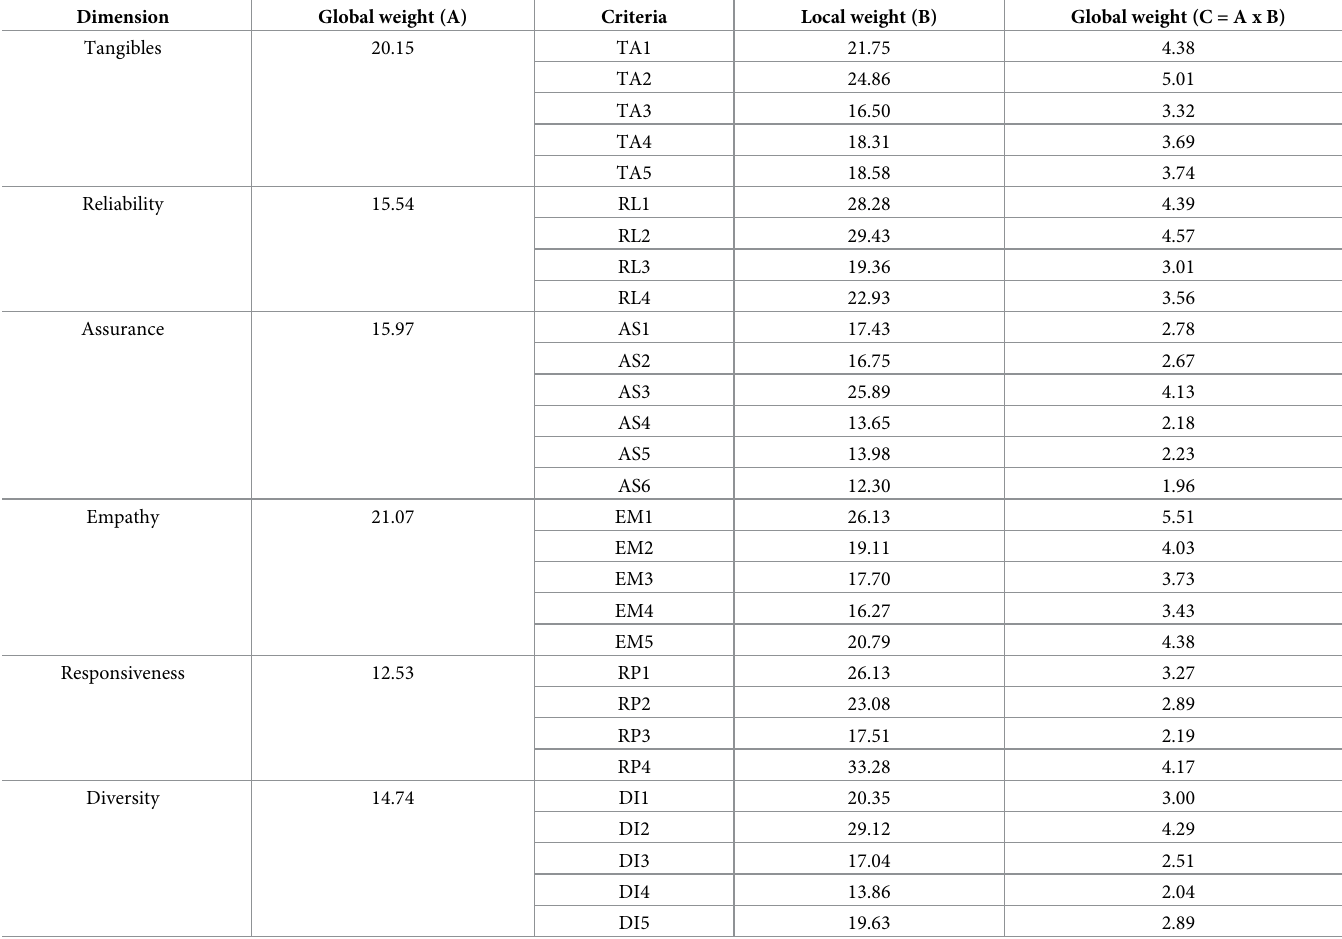
Table 8. The revised weights of SAs for importance measurement